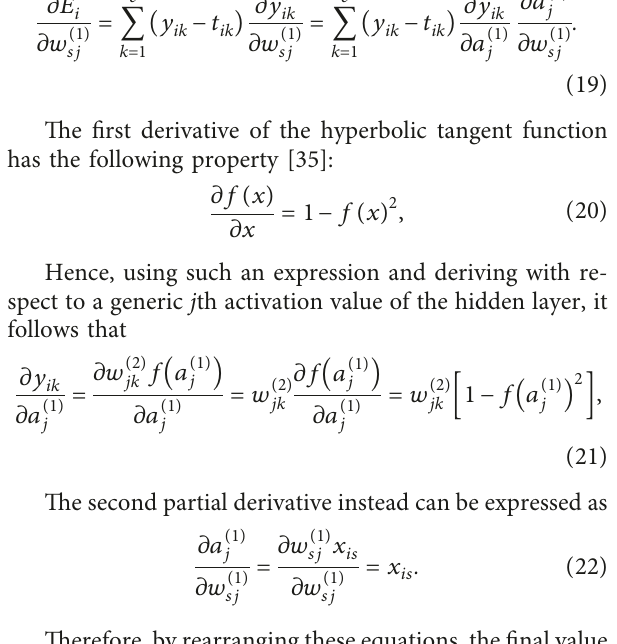
Table 1: Diabase aggregates characteristic properties.